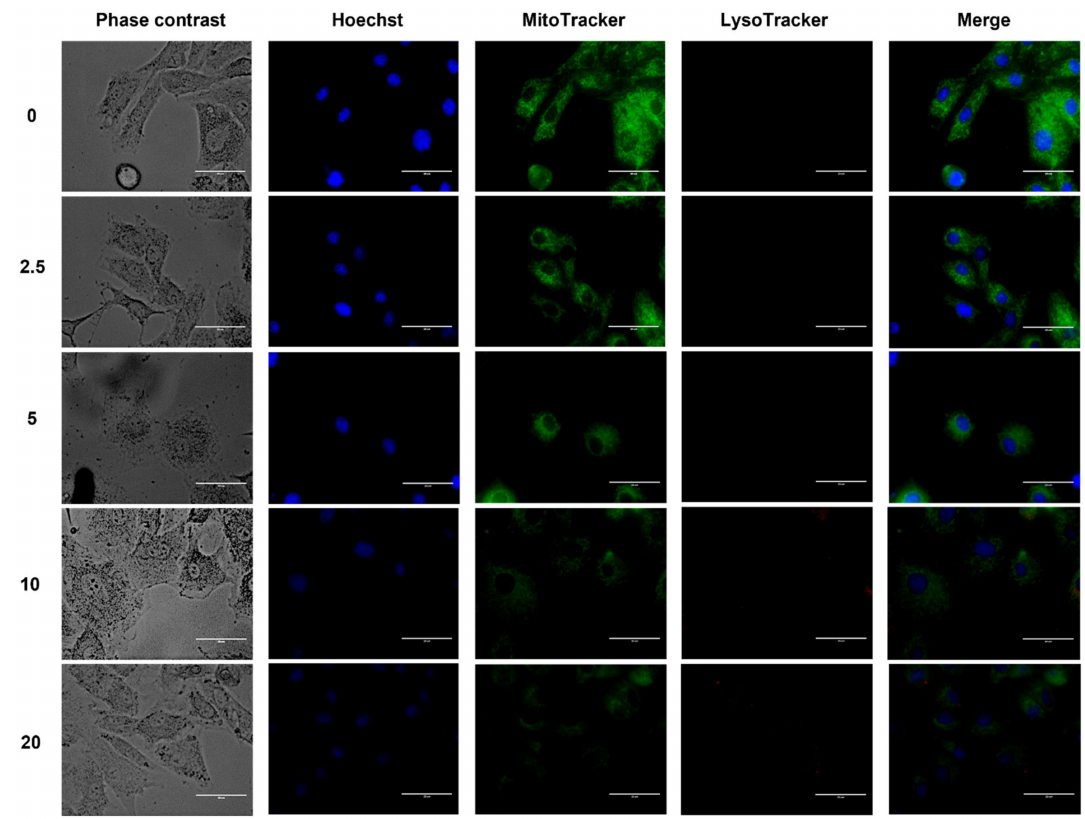
Figure 7. ZnO NPs effect on mitophagy. Cells were exposed to ZnO NPs (0, 2.5, 5, 10, and 20 µ g/cm 2 ) over 6 h. Cells were cultured in DMEM in glass-bottom culture dishes. Cell loading protocol was performed as indicated in the Material and Methods section. Bars = 50 µ m.